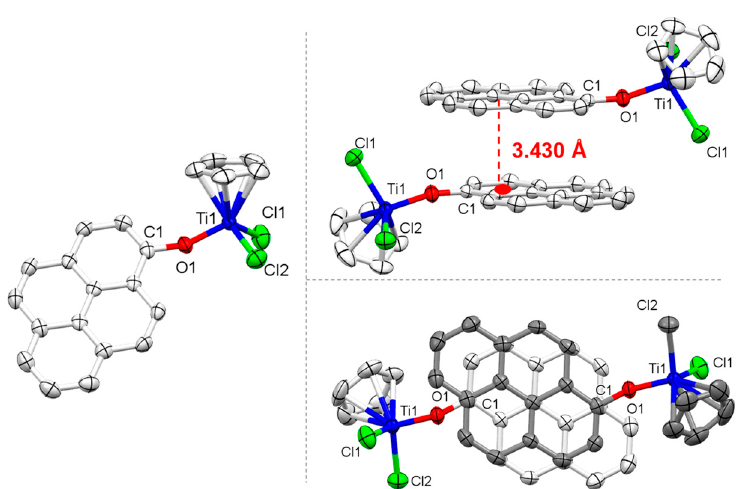
Figure 2. Single crystal packing diagram of complex Ti1 .